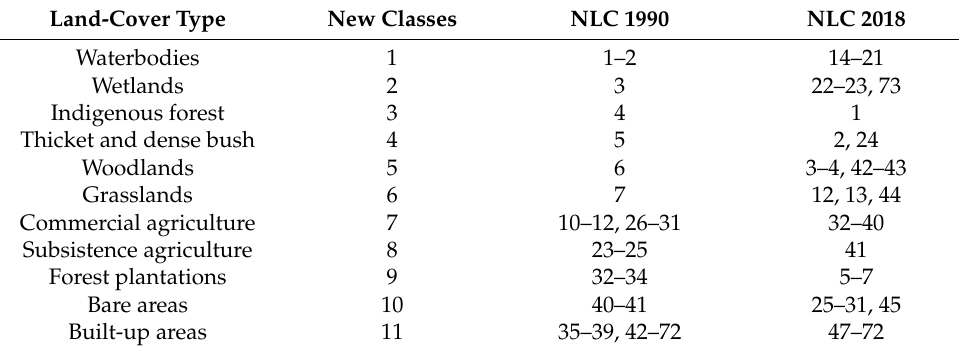
Table 1. Standardised land-cover classes for changes between 1990 and 2018 [39].